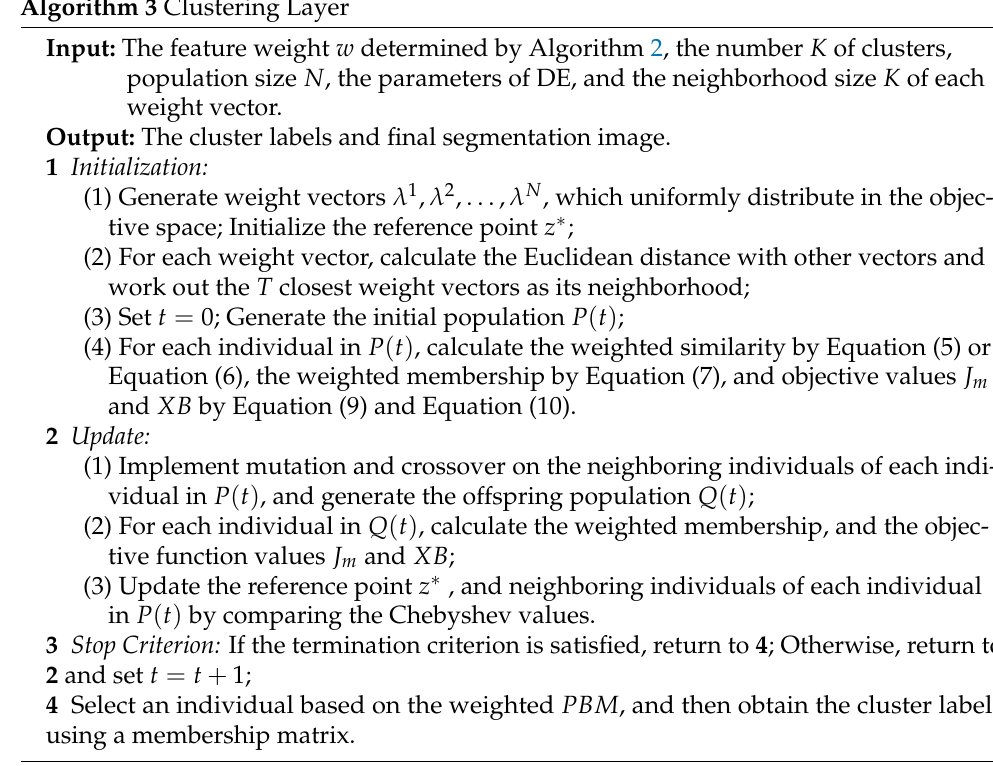
Algorithm 3 Clustering